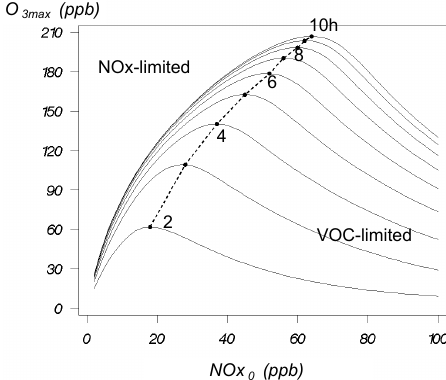
Fig. 9. An example of O 3max growth and changes of the regime boundary (denoted by the dashed line) with normalized distance D for an initial VOC concentration of 500ppbC ( L =2h). Fig. 10. Changes of regime boundary α (VOC